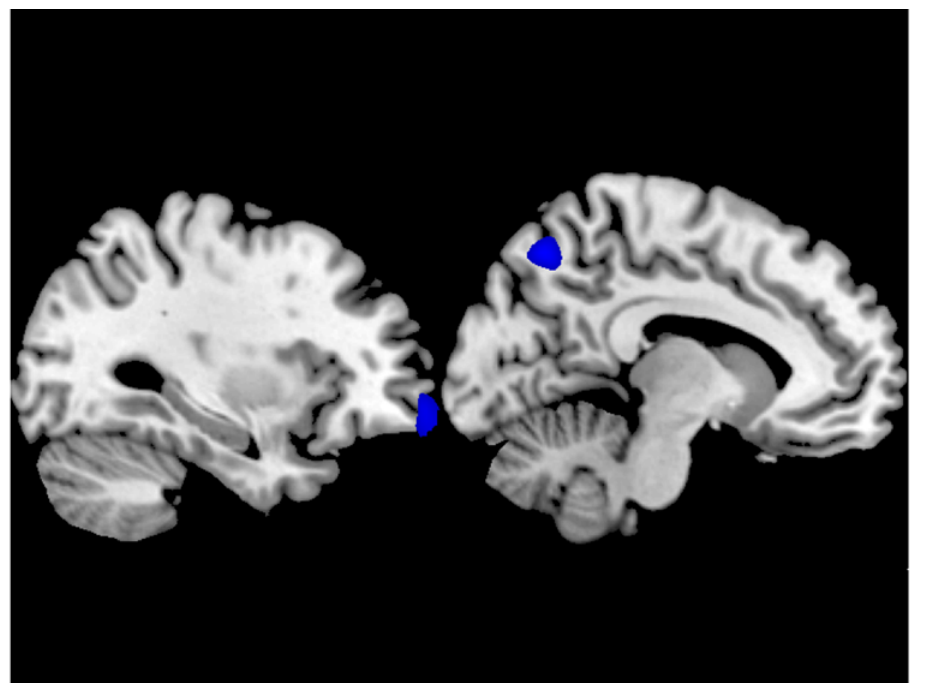
Figure 3. Experiencing fear of God’s anger negatively correlated with cortical volume at the L precuneus, BA 7 and the L orbitofrontal cortex, BA 11. Threshold was set to p , 0.001 uncorrected for visualization.